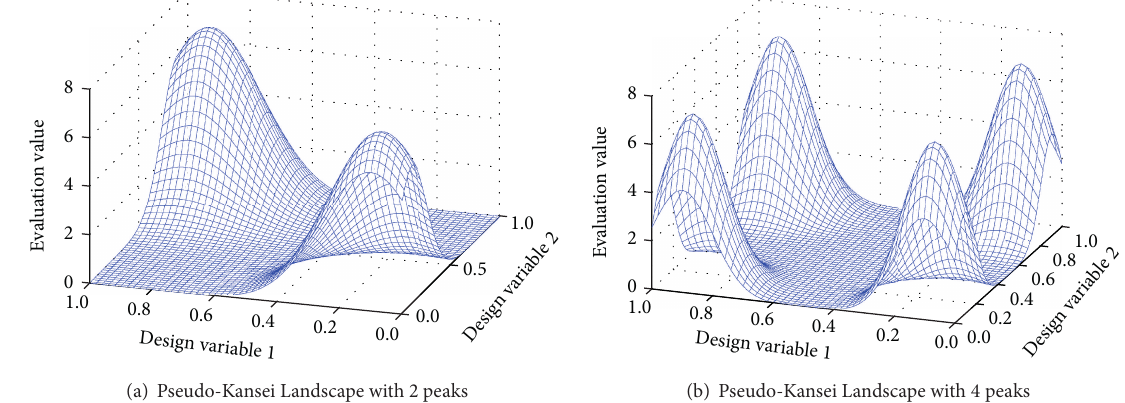
Figure 7: Examples of 2-dimensional pseudo-user